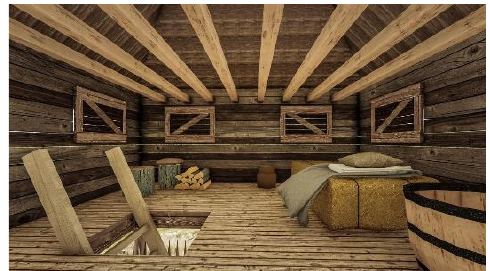
Figure 11. Interior of the guard room [70].